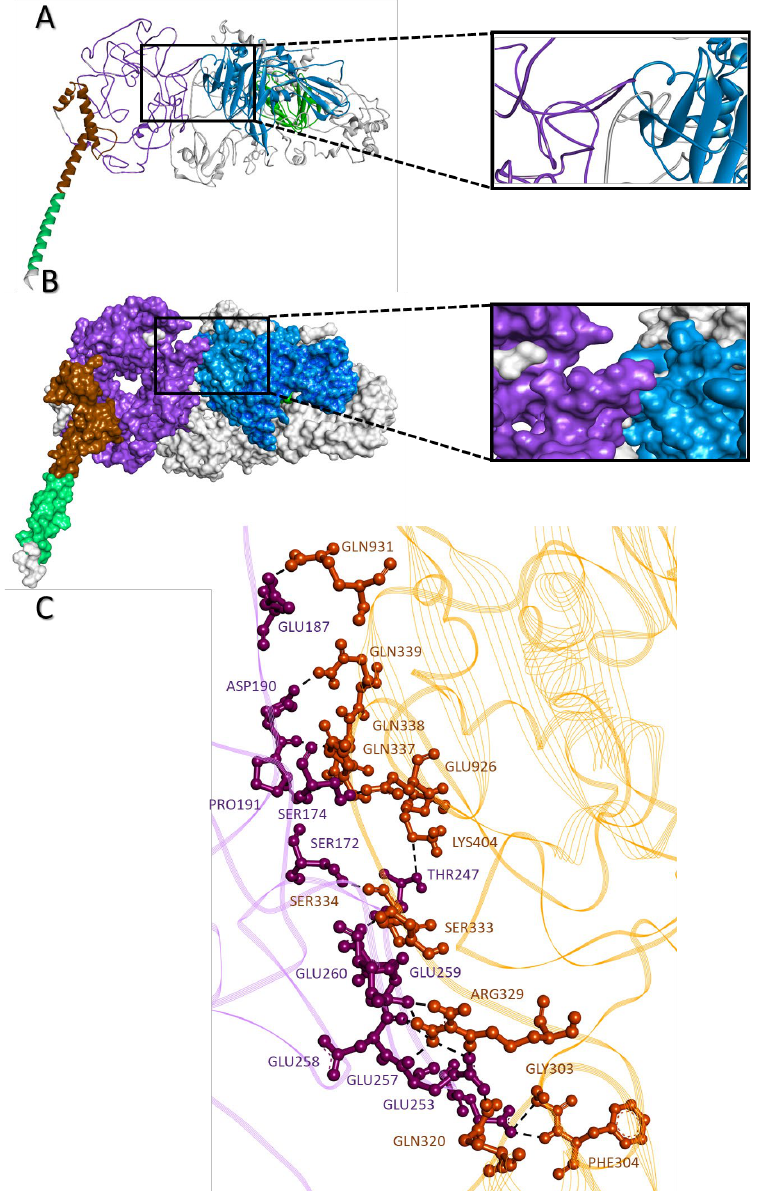
Figure 9. c-MYC-USP37 molecular complex. Intermolecular complexes between c-MYC and USP37 are shown in ( A ) ribbon configuration and ( B ) surface topology along with the magnified interaction regions. ( C ) Ball and stick representation of intermolecular interactions between amino acids of c-MYC (purple) and USP37 (orange), where the dotted lines represent intermolecular hydrogen bonds.